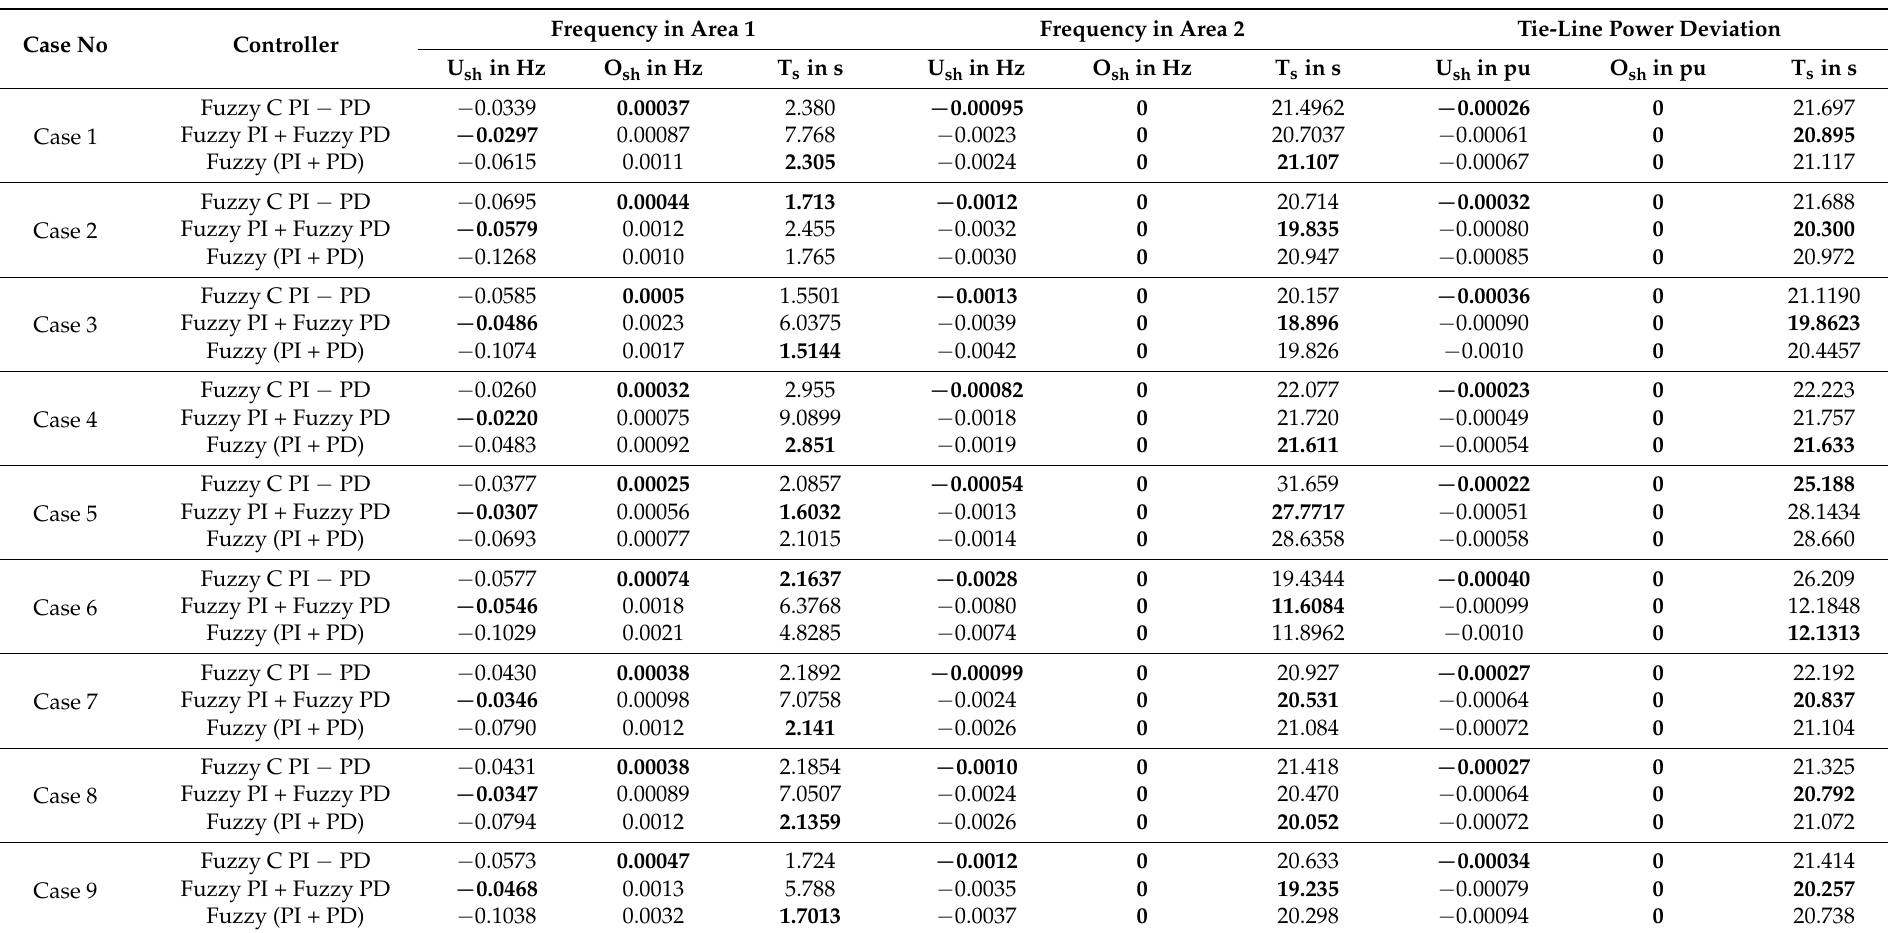
Table 12. Dynamic response of the system under different parametric uncertainties scenarios with different